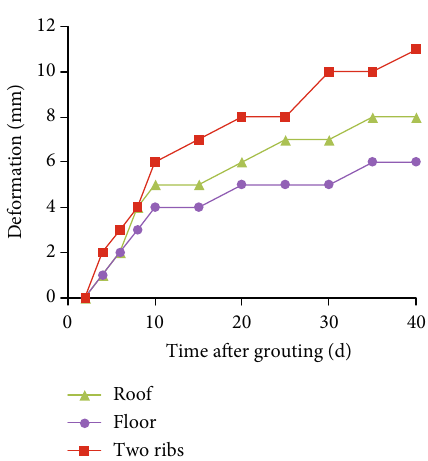
Figure 9: The roadway deformation after